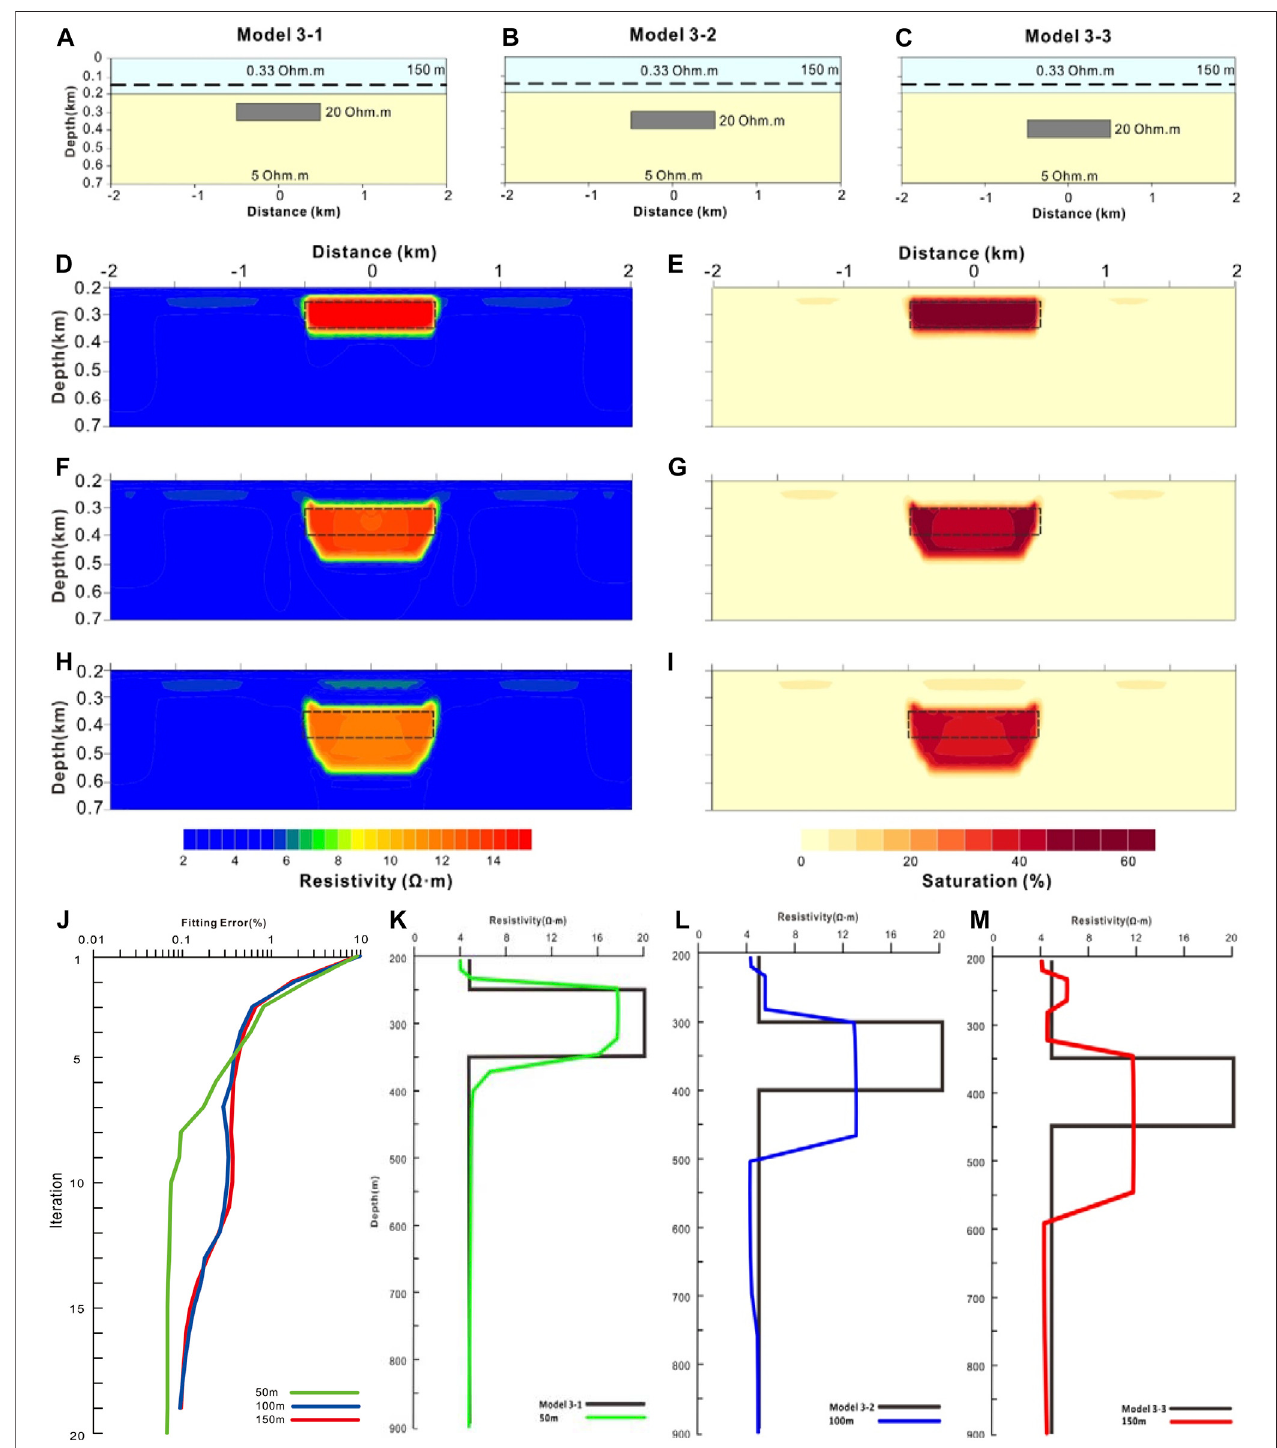
FIGURE6| Resistivityinversionandhydratesaturationestimationofvariousburieddepthsatthetopofthereservoir. (A) – (C) :theschematicdiagramofModel3 – 1, 3-2, and 3-3respectively, lightblue indicates seawater,lightyellow indicates marine sediments, gray block indicates hydrate reservoirs, dotted lineindicates thetrackof thetowedDCRarray; (D) , (F) and (H) :theinversionresistivityofModel3 – 1,3-2,and3-3,respectively; (E) , (G) and (I) :thehydratesaturationofModel3 – 1,3 – 2,and3 – 3, respectively (J) :theinversioniterationconvergenceofModel3 – 1(green),3 – 2(blue)and3 – 3(red),respectively (K) – (M) :theresistivitypro fi lewithdepthatthecenter x position of hydrate reservoir of Model 3 – 1(green), 3 – 2(blue) and 3 – 3 (red), respectively.